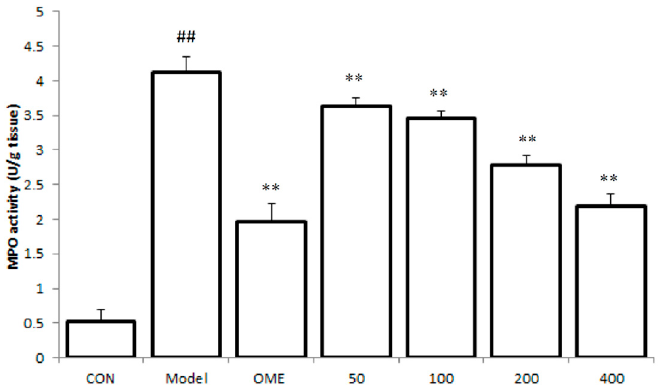
Figure 3. Effect of LCA on MPO activity. Data are expressed as the mean ± SD ( n = 8). ##: p < 0.01 vs. control group. **: p < 0.01 vs. model group. (CON = control; OME = omeprazole).